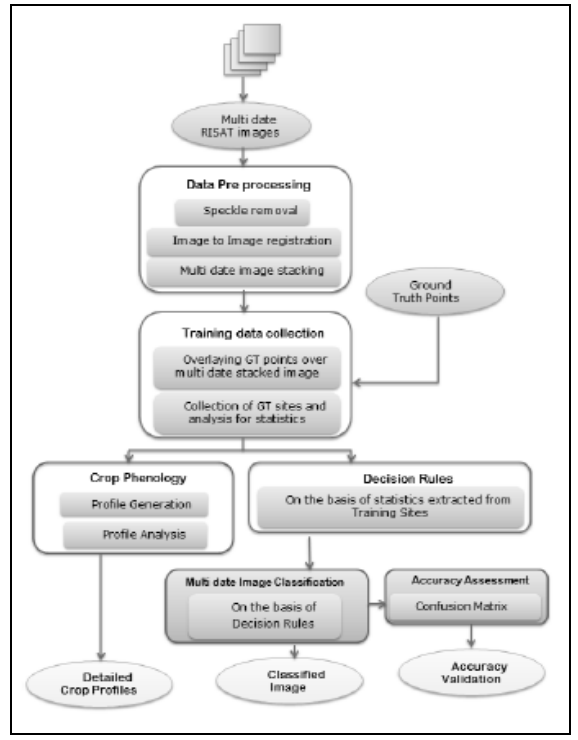
Figure 3: Flow chart of methodology followed in SAR data